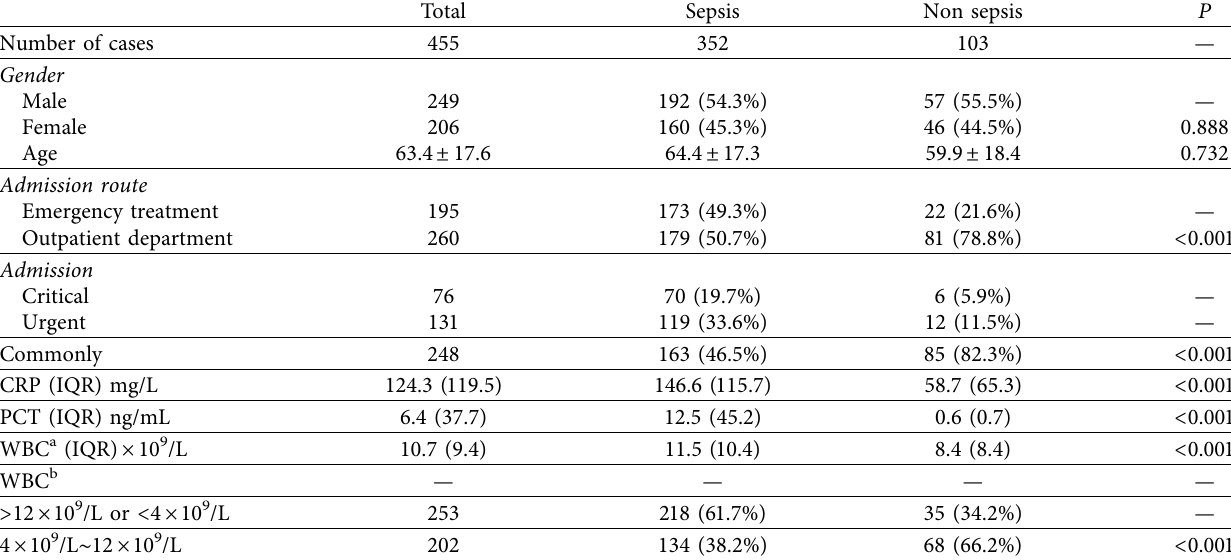
Table 8: Comparison of clinical data between sepsis and nonsepsis patients.